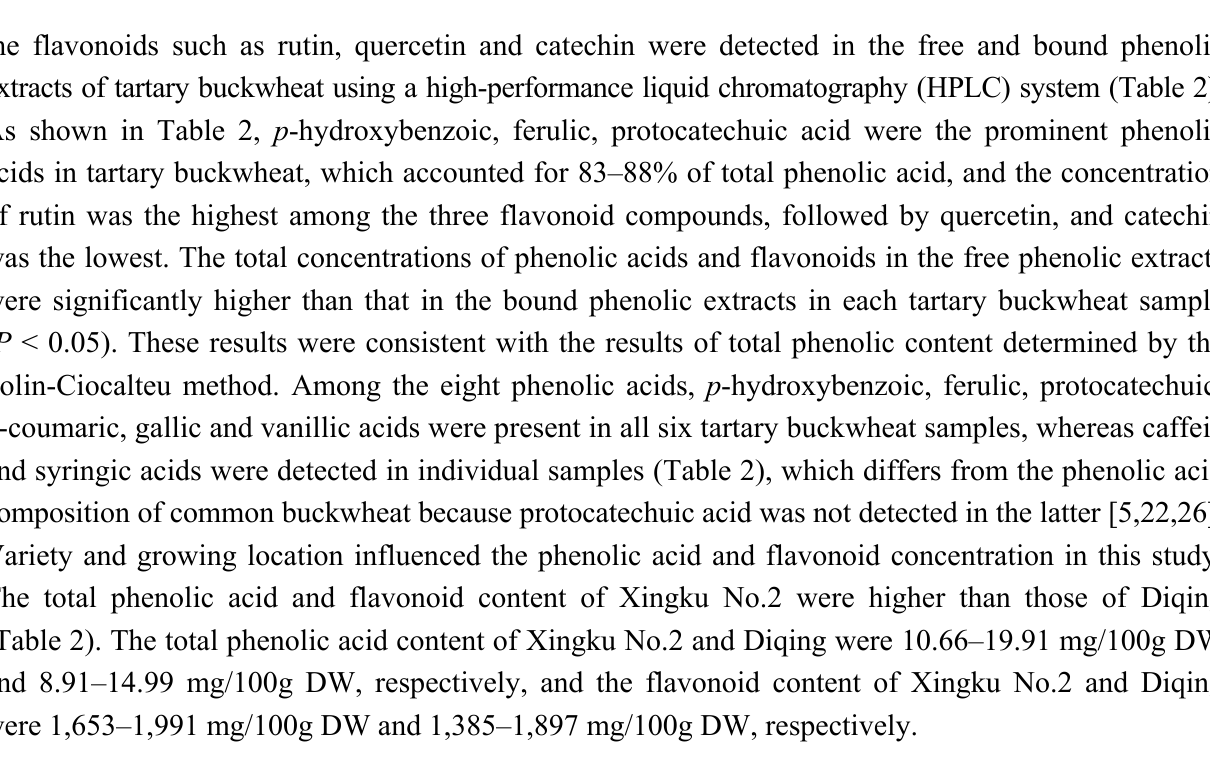
Table 2. Flavonoid and phenolic acid composition in tartary buckwheat seed.